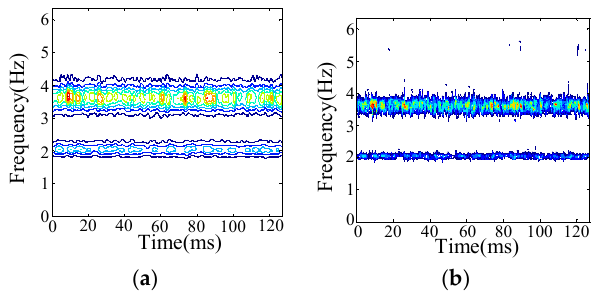
Figure 20. Improved wavelet scalogram analysis. ( a ) Reassigned scalogram; ( b ) Scalogram under synchronous averaged.